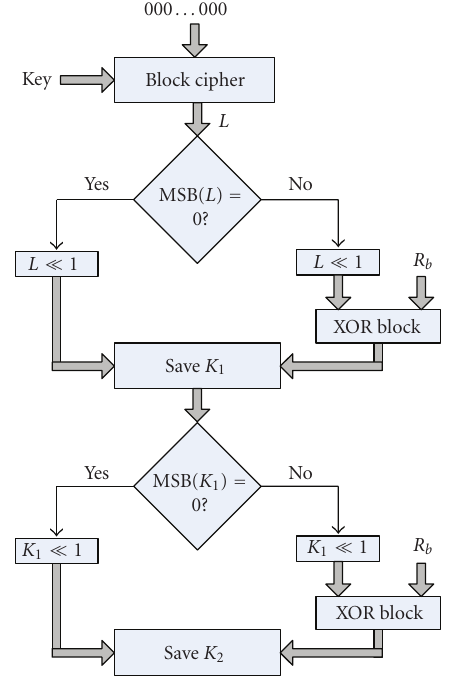
Figure 1: Subkeys generation